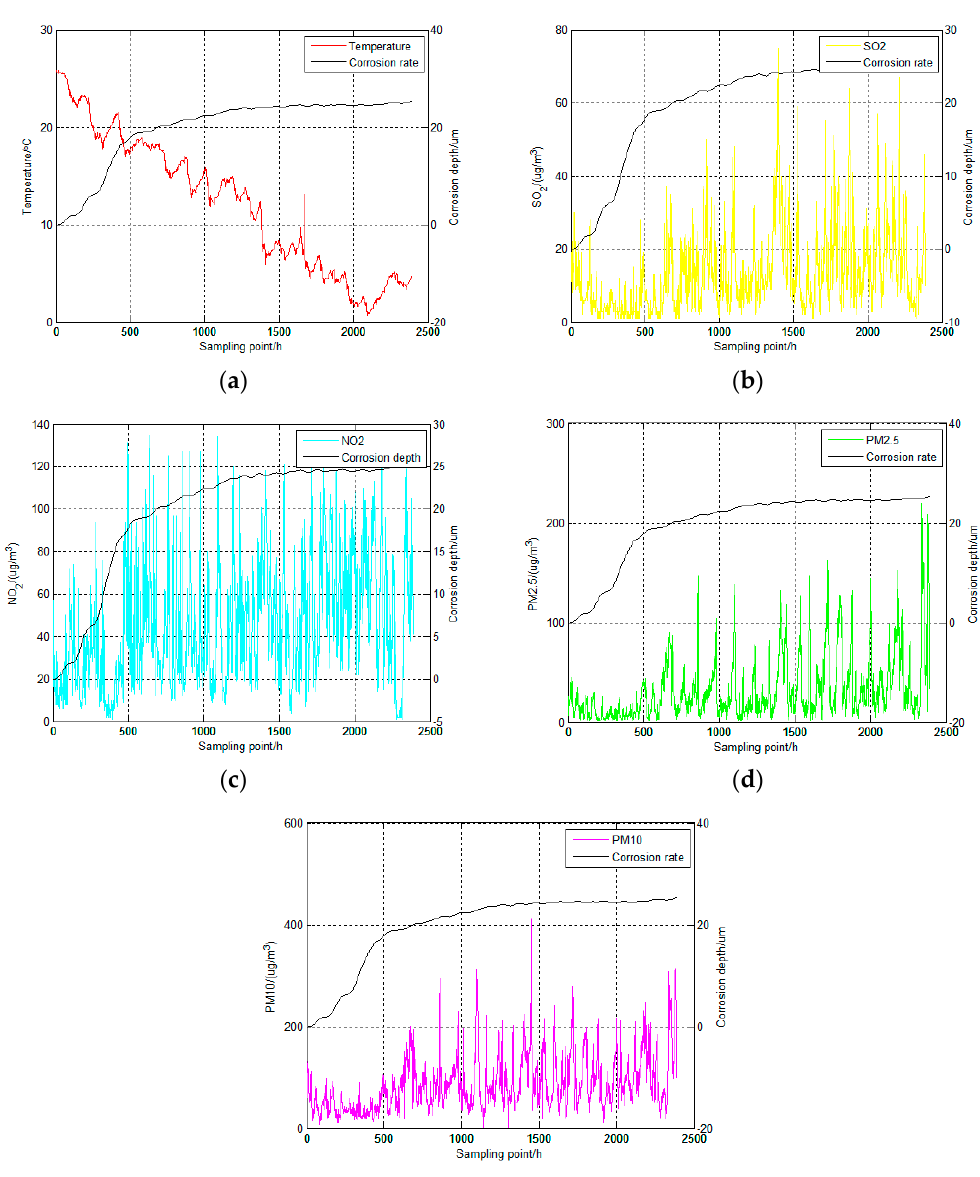
Figure 9. Detailed information about corrosion depth and atmospheric environmental elements. ( a ) The relationship between corrosion depth and T; ( b ) The relationship between corrosion depth and SO 2 ; ( c ) The relationship between corrosion depth and NO 2 ; ( d ) The relationship between corrosion depth and PM2.5; ( e ) The relationship between corrosion depth and PM10.